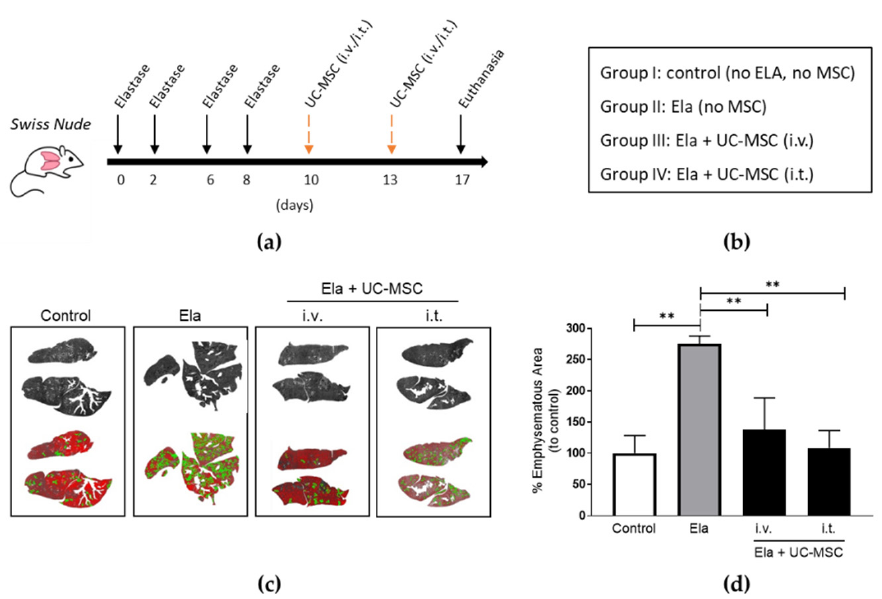
Figure 3. Human UC-MSC administrated either intravenously (i.v.) or intratracheally (i.t.) reduced lung emphysema in elastase-treated mice. ( a ) Schematic timeline and ( b ) groups of the elastase and MSC treatments included. Images of digital evaluation ( c ) and quantification and statistics ( d ) of the emphysematous areas of the murine lungs. One-way ANOVA, Tukey post-test ** p < 0.005. Abbreviations: AD-MSC (adipose tissue MSC), UC-MSC (umbilical cord MSC), Ela (elastase), i.v. (intravenously), i.t. (intratracheally).